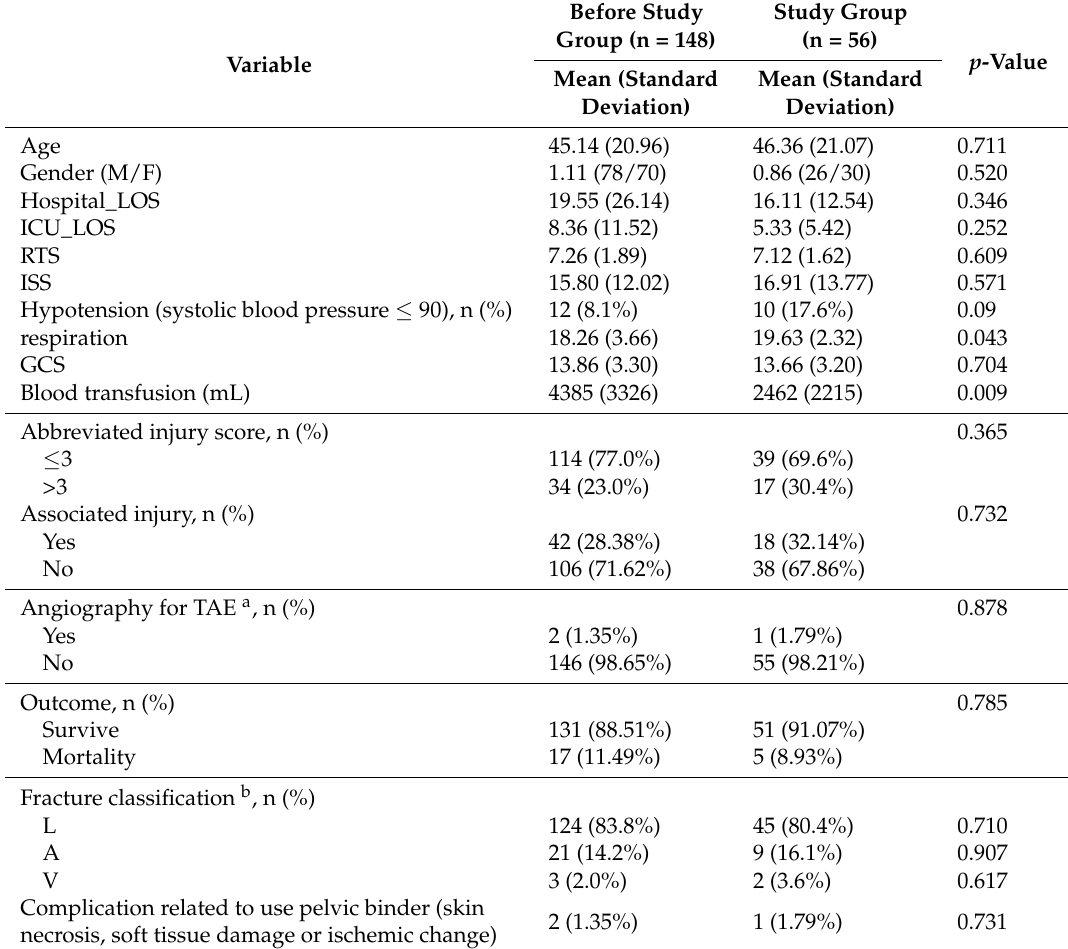
Table 1. Baseline patient